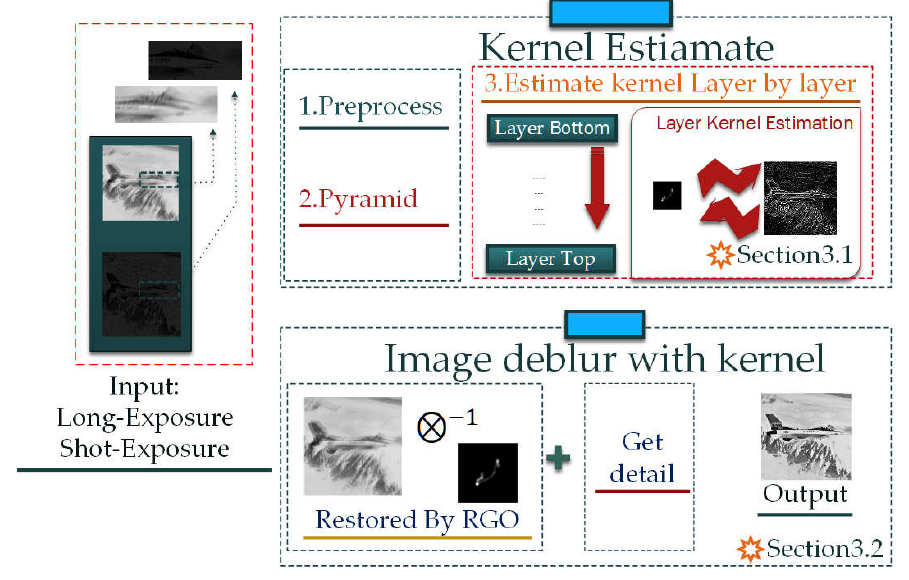
Figure 1. Structure flow